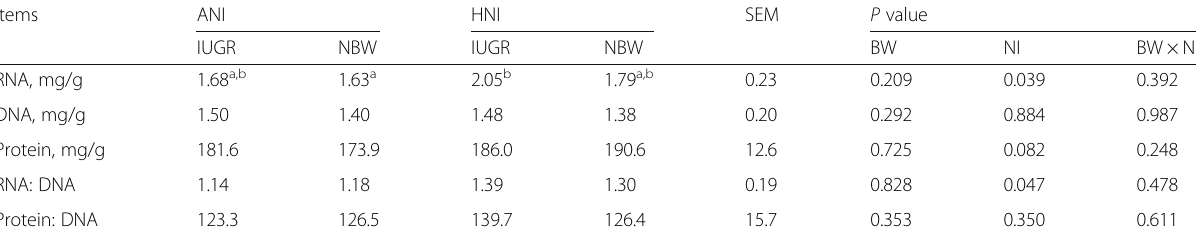
Table 5 Effects of the level of nutrient intake on the concentrations of RNA, DNA, and protein in psoas major muscle of intrauterine growth-restricted (IUGR) and normal birth weight (NBW) pigs Items ANI